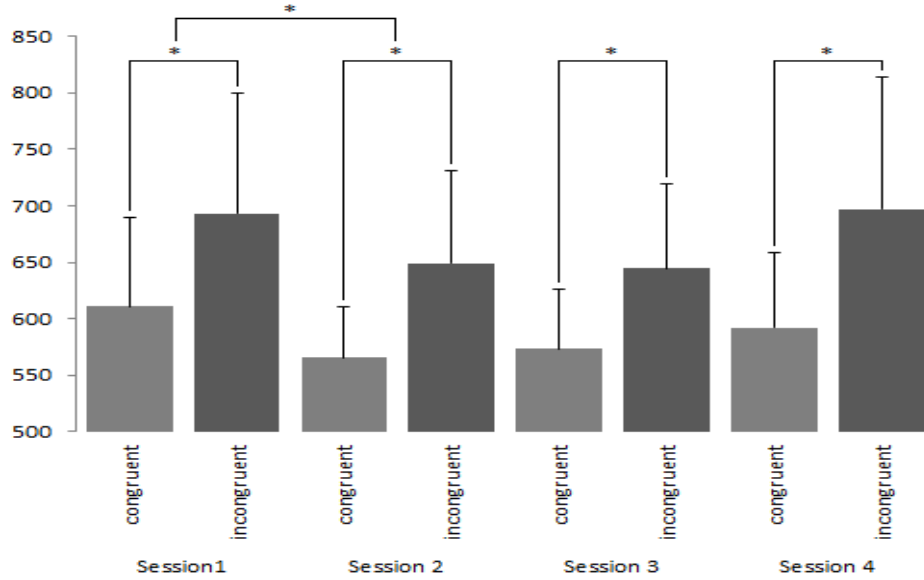
Figure 4. IAT results (in milliseconds) reflecting responses towards disliked brands in the congruent and incongruent phases. Whilst significant differences were witnessed between the congruent and incongruent phases, reaction times were not seen to vary across sessions. * denotes p < 0.001.